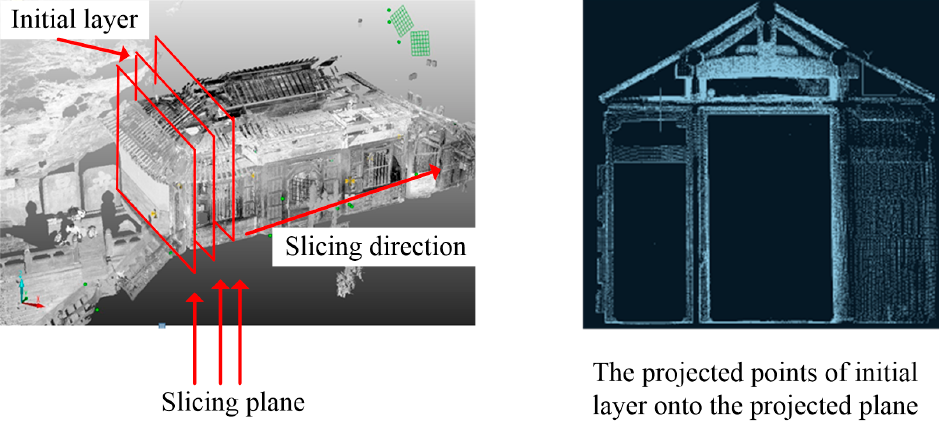
Figure 11. Point cloud slicing and projection.